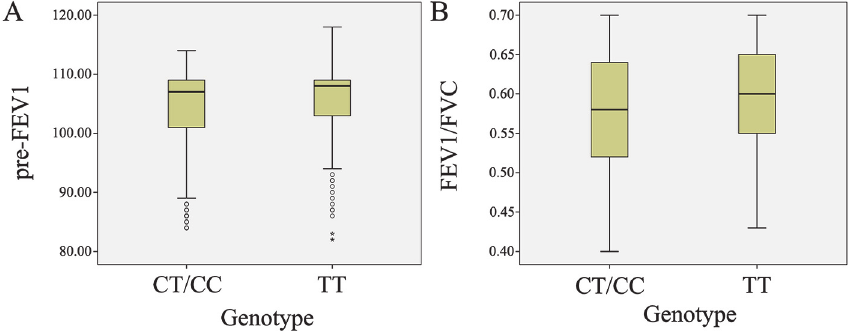
Fig 1. The association between ABHD2 polymorphism rs12442260 and pulmonary function under a dominant model. (A) Rs12442260 is associated with pre-FVE1 in controls; (B) Rs12442260 is associated with FEV1/FVC ratio in patients with